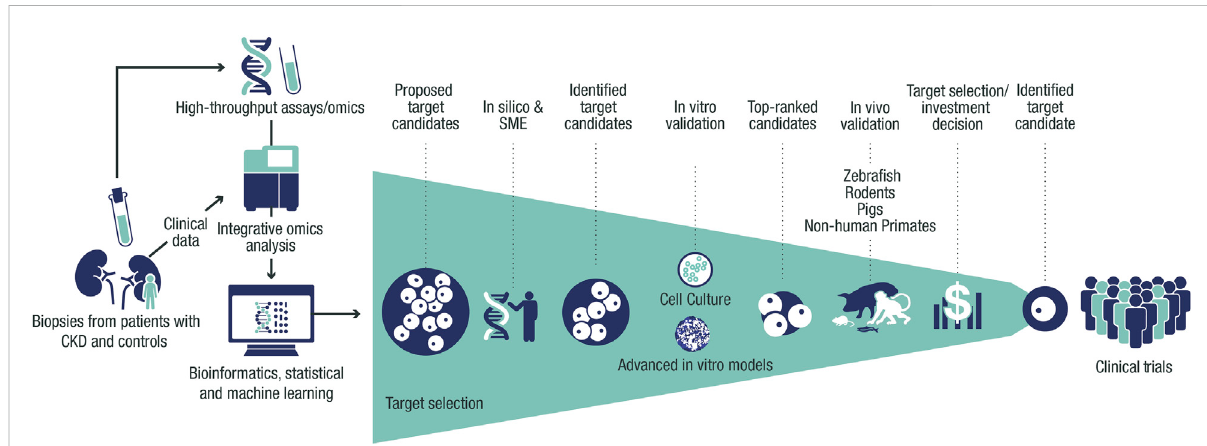
FIGURE 1 Frameworkfortargetidenti fi cationandvalidationinCKD.PotentialCKDtargetsidenti fi edfromhumandata viainsilico andSMEapproachesare prioritized using thorough validation in vitro and in vivo systems, facilitating target selection. Target identi fi cation starts with the collection of biopsies, urine, and blood from patients with CKD and controls from clinical trials and collaborations. Omics data (genetic, transcriptomic, proteomic,andmetabolomic)arethengeneratedfromthesesamplesandprocessedwithintegrativeomicsanalysesfollowedbybioinformatic and statistical analyses and machine learning. This data processing results in a list of CKD targets that is assessed in silico to build further evidence of humantarget – diseaseassociations.Theshortlistedtargetsarethenprioritizedbyapplyingbiologicallyrelevant invitro validationinculturedcellsand advanced in vitro models. The targets with the strongest supportive data are then validated further in vivo to build proof-of-mechanism and proof- of-principle in CKD before being presented for target selection and investment decision to enter the portfolio. CKD, chronic kidney disease; SME, subject-matter